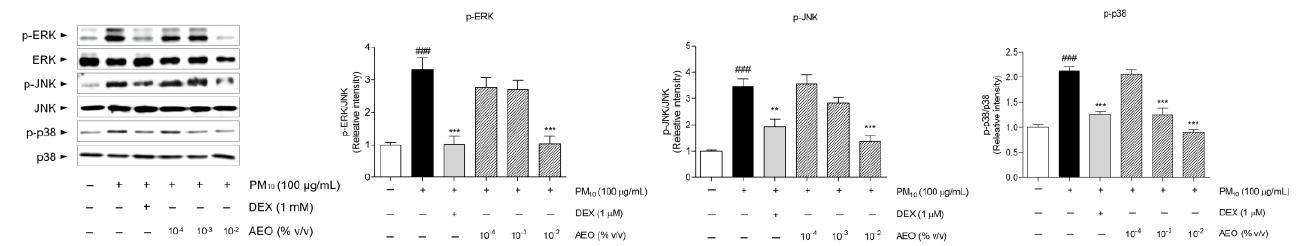
Figure 7. AEO reduced expression levels of p-ERK, p-JNK, and p-p38 in PM 10 -induced human nasal epithelial cells. The protein levels of p-ERK, p-JNK, and p-p38 were analyzed by western blot assay. The data are presented as the means ± standard error of the mean. ### p < 0.001 compared to the NOR group. ** p < 0.01, *** p < 0.001 compared to PM 10 -treated group.